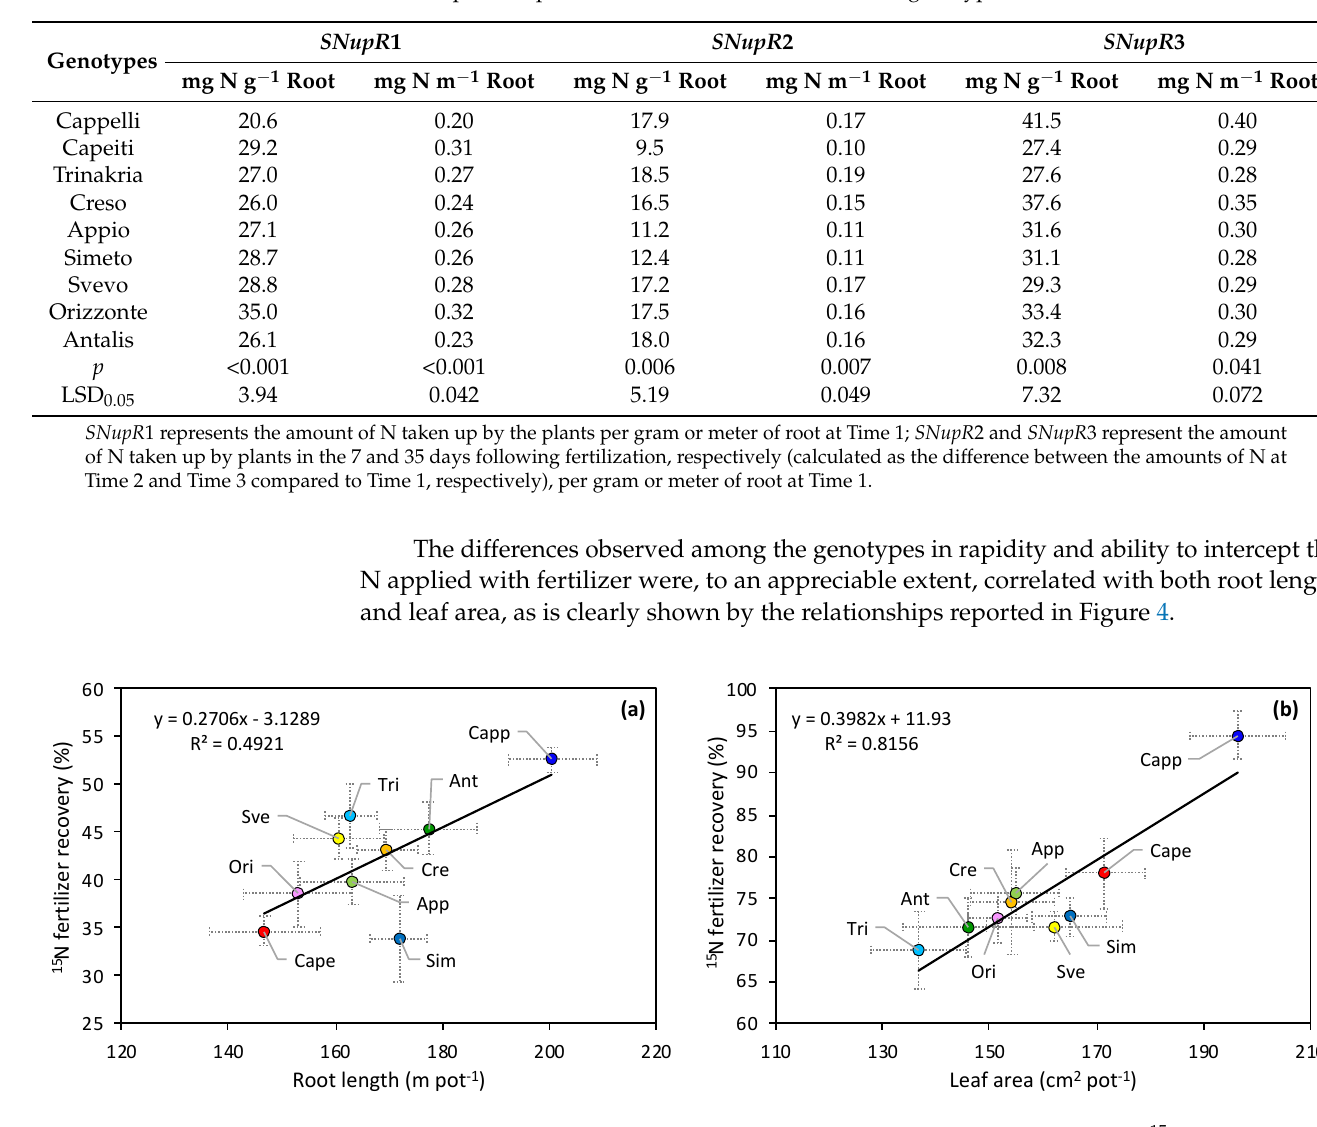
Table 3. Specific uptake ratios of N for the nine studied genotypes.